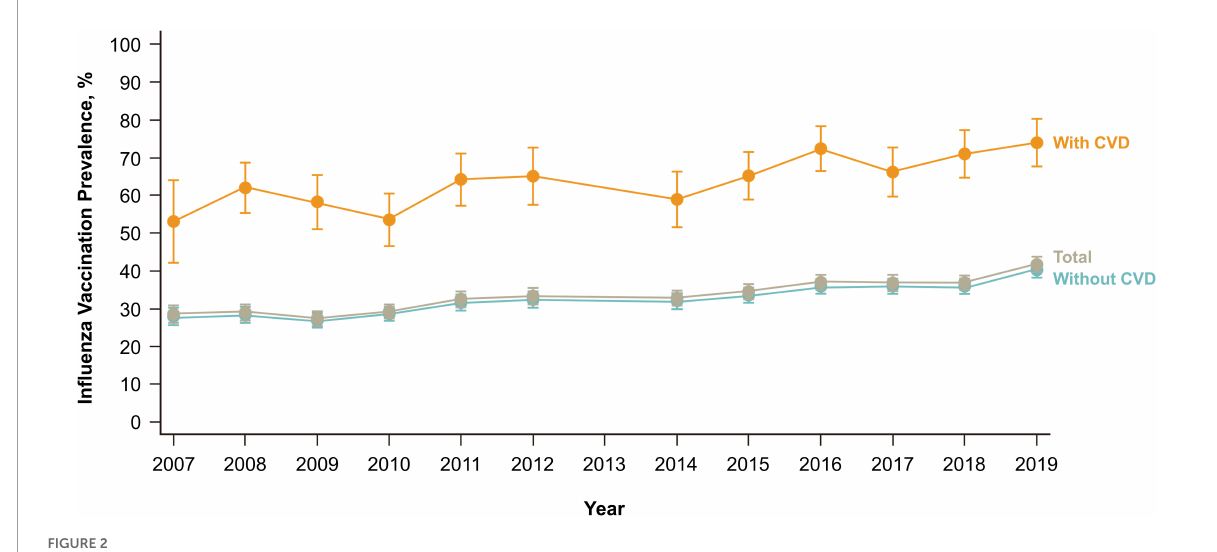
FIGURE2 Influenza vaccination trends over 9 years according to the cardiovascular disease history. CVD, cardiovascular disease.